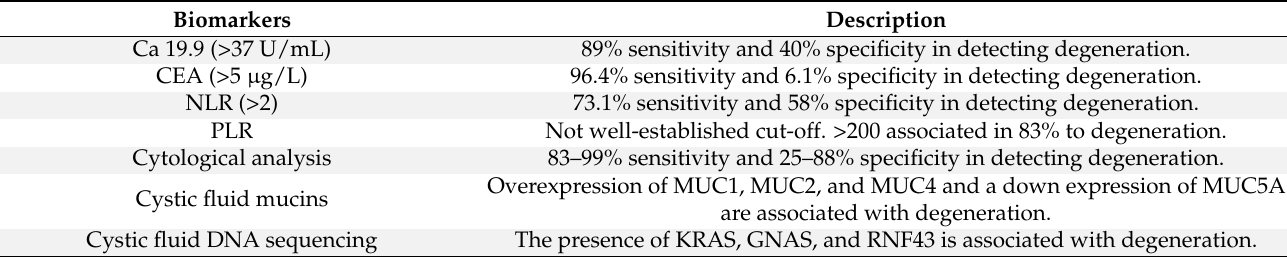
Table 2. Humoral biomarkers predictors of degenerate